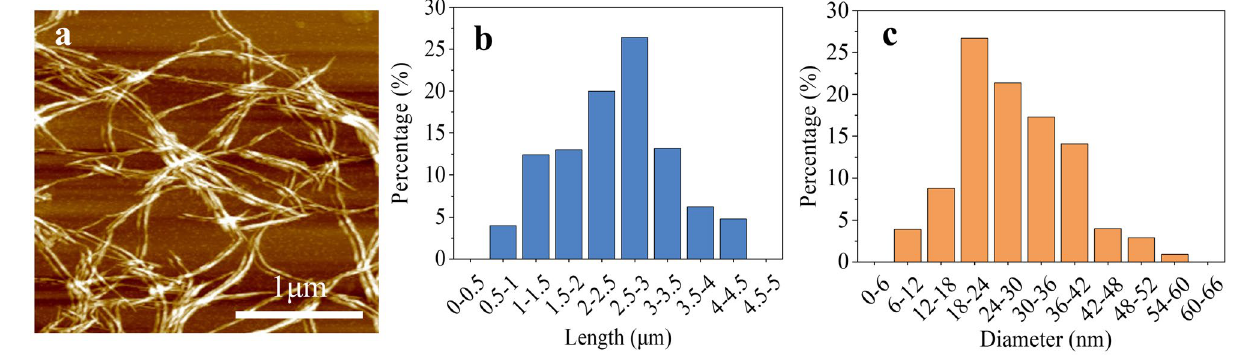
Figure 3. Atomic force microscope images of ( a ) CNFs; ( b ) CNF length and ( c ) CNF